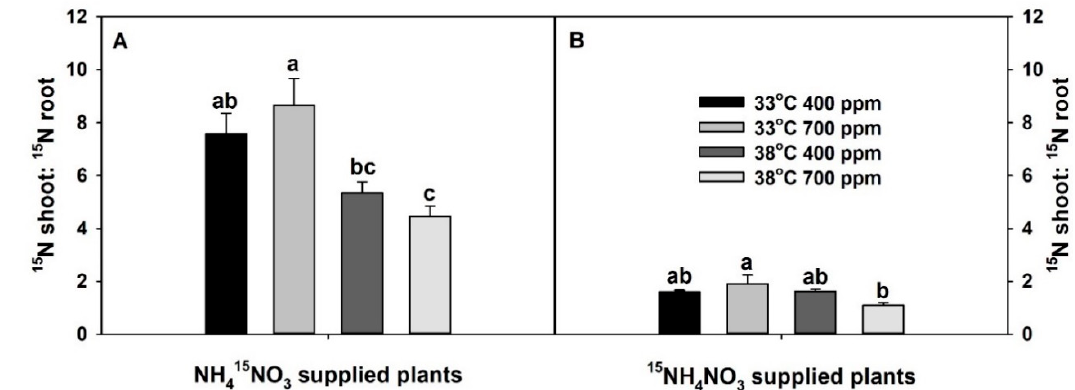
Figure 3. Effects of ambient (400 ppm) vs. elevated (700 ppm) CO 2 and near-optimal (33 °C) vs. chronic warming (38 °C) day-time temperatures on the ratio of total 15 N content in the shoots vs. roots of Solanum lycopersicum labeled for 3 days with 1 mM ( A ) NH 4 15 NO 3 or ( B ) 15 NH 4 NO 3 and grown for 21 or 23 days, respectively. Each bar represents mean ( n = 5) + 1 SEM. Within each panel, bars not sharing the same letters are significantly different ( p < 0.05, Tukey’s test).